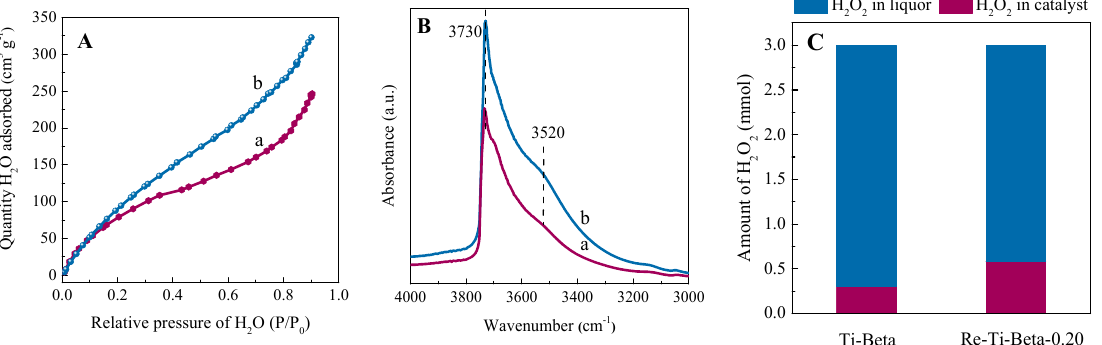
Figure 9. H 2 O adsorption isotherms ( A ) and FT − IR spectra ( B ) in the hydroxyl stretching region of Ti − Beta (a) and Re − Ti − Beta − 0.20 (b) at 298 K. The adsorption ( C ) of H 2 O 2 on Ti − Beta and Re − Ti − Beta − 0.20. Adsorption conditions: 50 mg of dried catalyst; 3 mmol H 2 O 2 in MeCN, 5 mL; temp., 273 K (ice–water bath); time, 1 h.